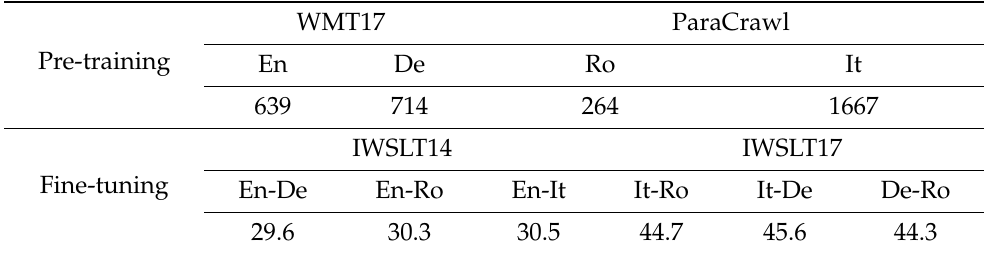
Table 1. Size/MB of each pre-training and fine-tuning